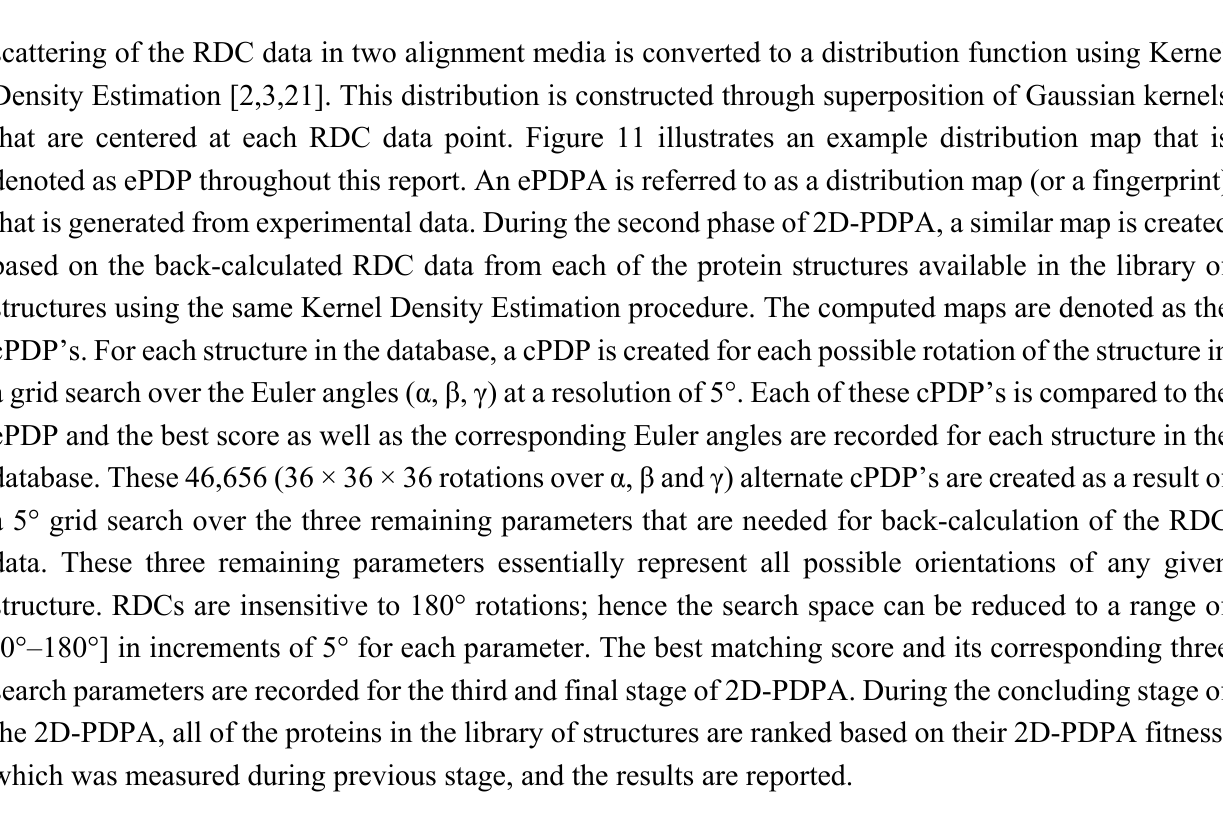
Figure 12. Operational schematic of the 2D-PDPA method illustrated in three main